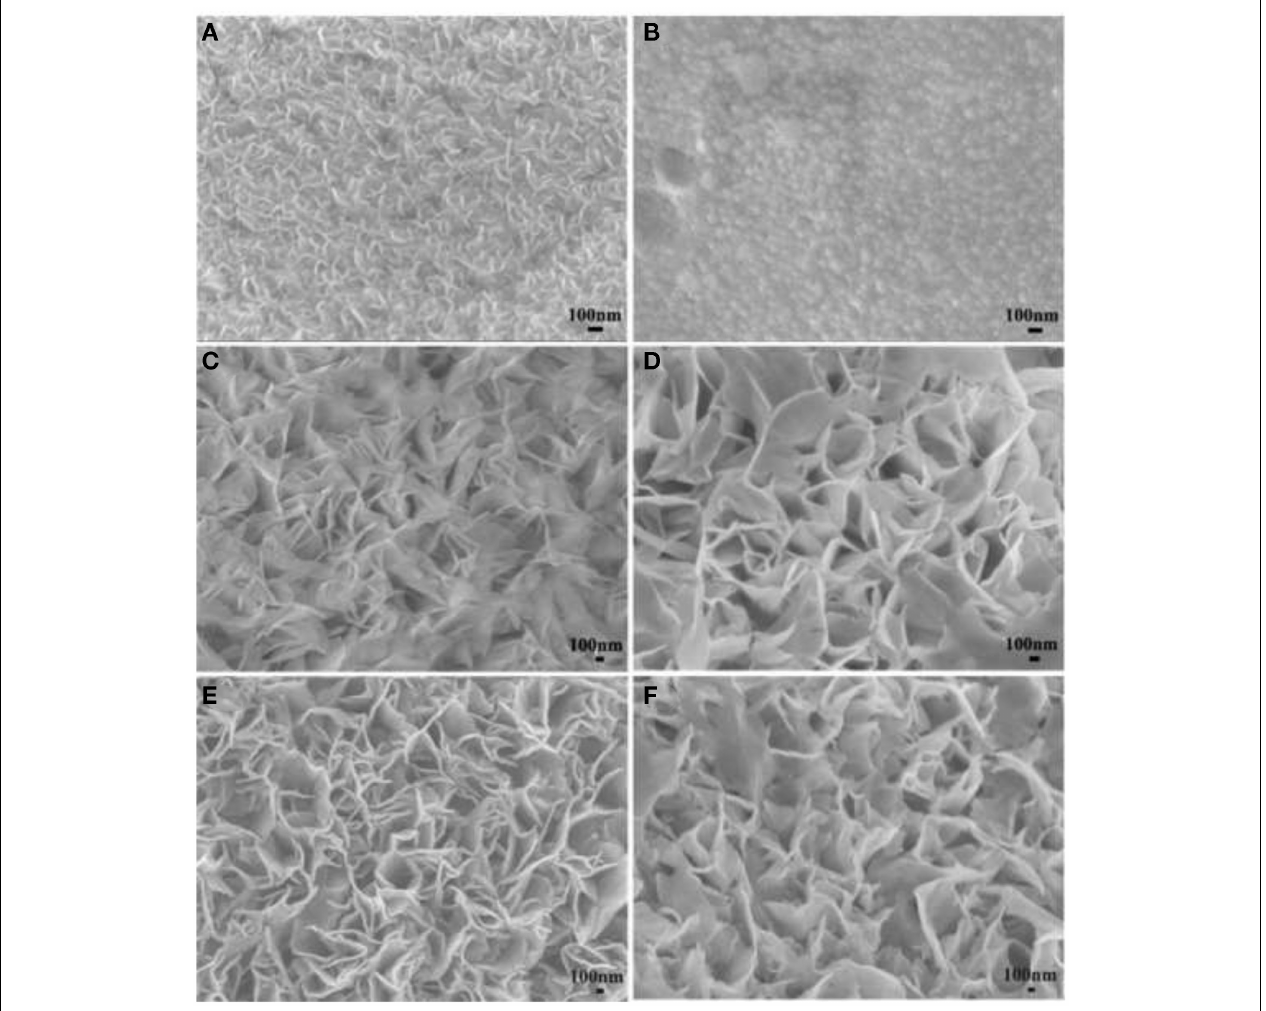
FIGURE 4 | SEM images for (A) GNS, (B) APC, (C) Co(OH) 2 /GNS, and (D) Co(OH) 2 /APC before discharge/charge cycles; (E) Co(OH) 2 /GNS and (F) Co(OH) 2 /APC after 2000 discharge/charge cycles . Obtained from Zhao et al.